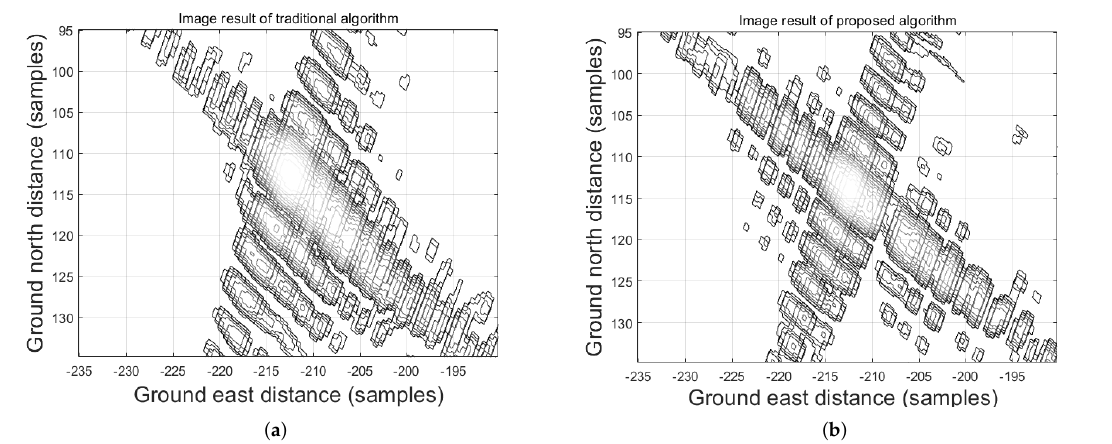
Figure 15. Contour image of the left transponder. ( a ) Image processed by the algorithm proposed in [41]. ( b ) Image processed by the algorithm proposed in this